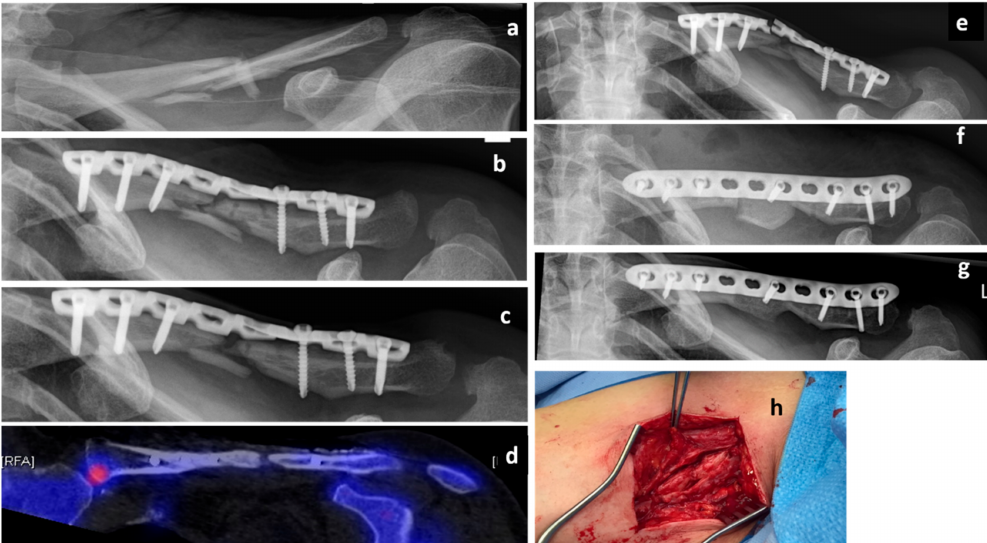
Figure 2. Case 2, x-rays presenting the initial clavicle fracture ( a ), after open reduction and internal fixation (ORIF) ( b ), and in the presence of a delayed union 6 months after trauma (c). A